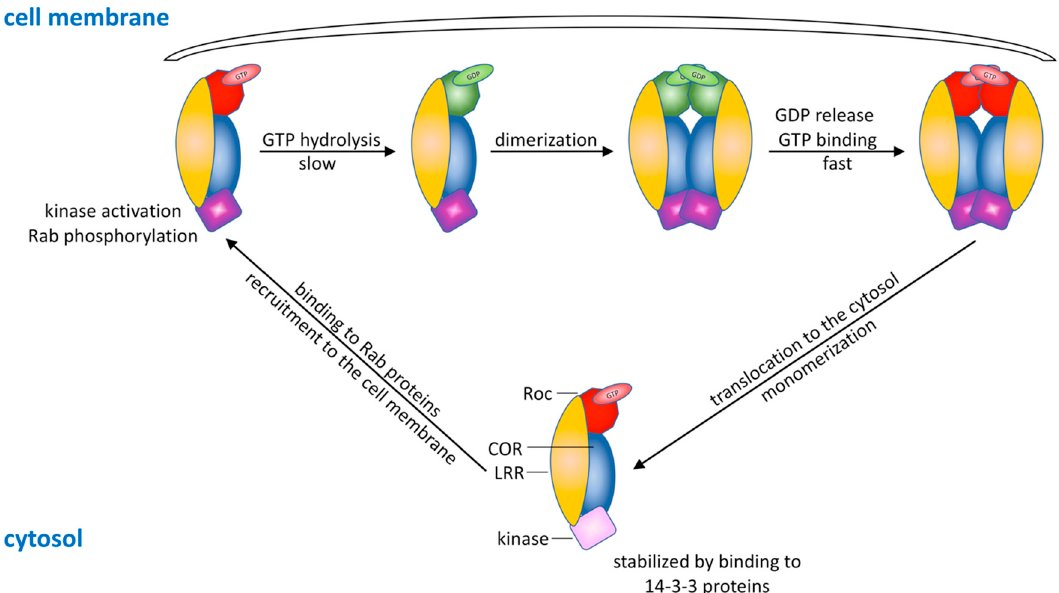
Figure 5. A newly proposed working mechanism for LRRK2. Cytosolic GTP-bound monomeric LRRK2 is recruited to the cell membrane by binding via its N-terminal domains to GTP-bound Rab proteins that are located at the membrane. At the cell membrane, GTP is hydrolysed, and the protein dimerizes. Meanwhile, the LRRK2 kinase domain is activated, and Rab proteins are phosphorylated. The low affinity of LRRK2 for GDP then leads to fast GDP release. Due to the higher GTP concentration present in the cell, this results in rebinding of GTP, monomerization of LRRK2 and return to the cytosol.